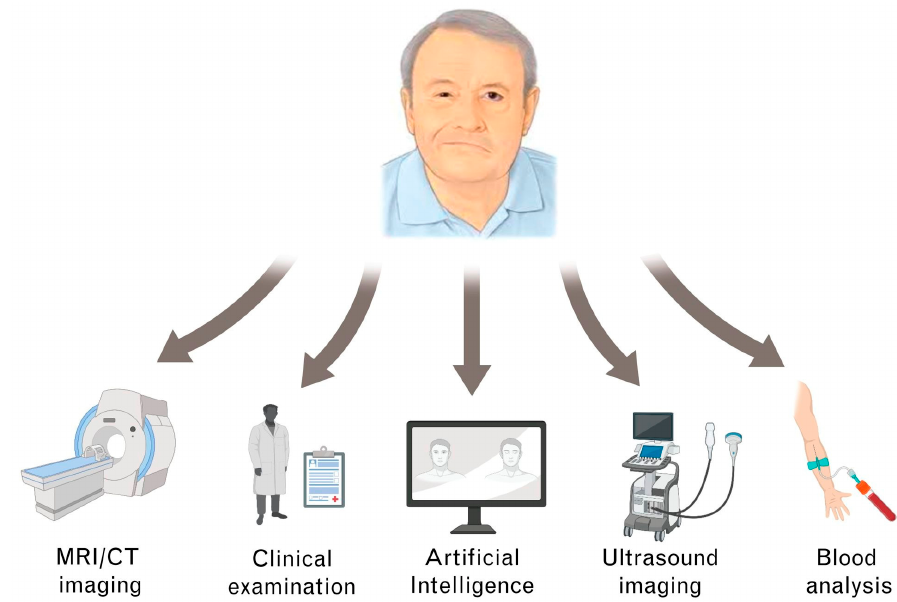
Figure 2. Different diagnostic pathways in facial palsy (FP) management.